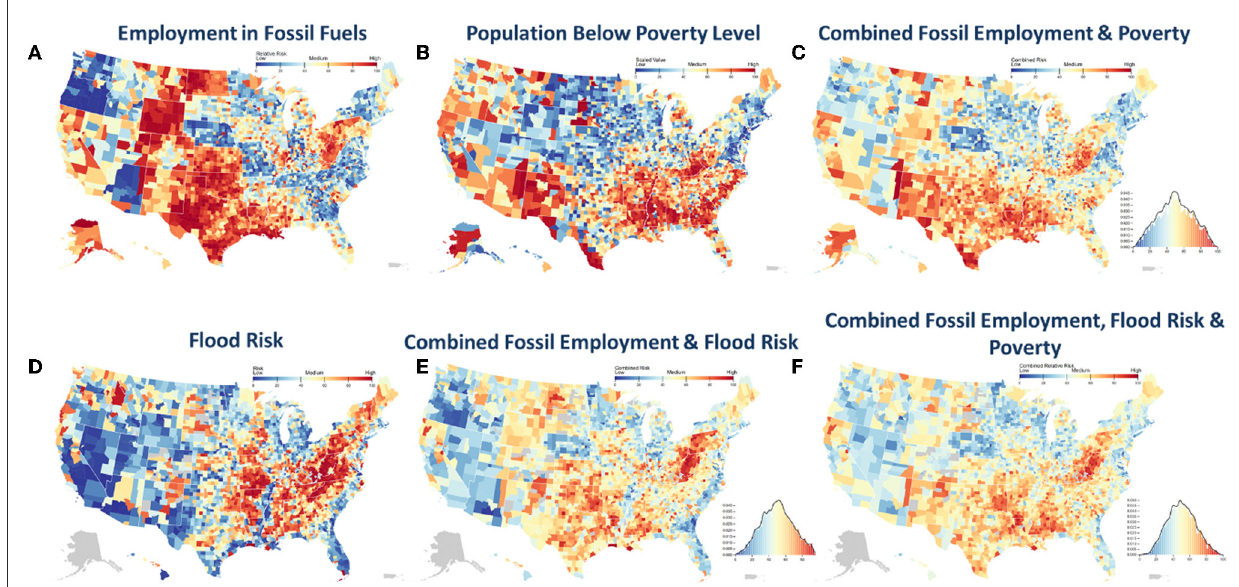
FIGURE9 Maps indicating transition and physical risks related to fossil fuels: (A) employment in fossil fuels (transition risk); (B) population below poverty level; (C) combined fossil employment and poverty (transition risk); (D) flood risk; (E) combined fossil employment and flood risk (physical risk); and (F) combined fossil employment, flood risk and poverty (both transition and physical